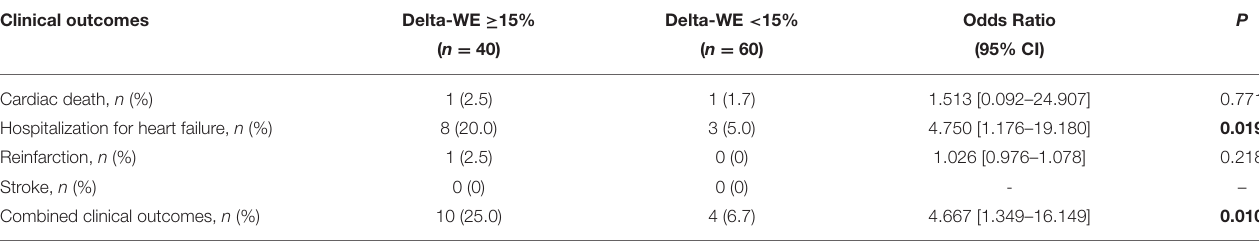
Abbreviations are same as in Table 3 . Significant P values are in boldface type.